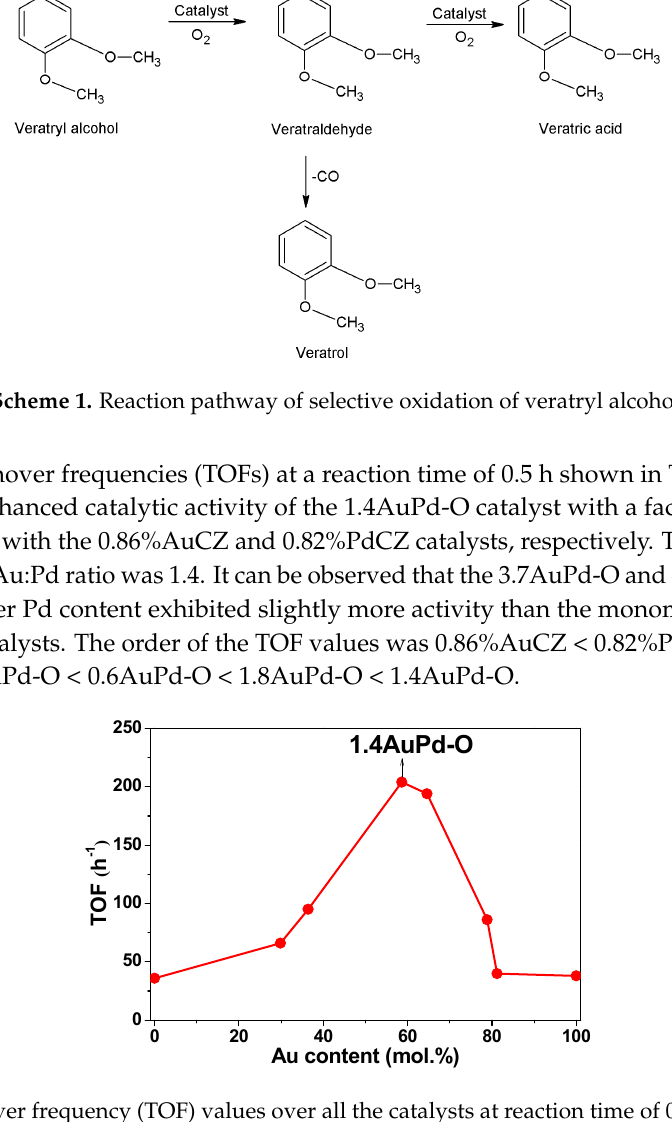
Figure 7. Turnover frequency (TOF) values over all the catalysts at reaction time of 0.5 h for selective oxidation of veratryl alcohol to produce veratraldehyde.